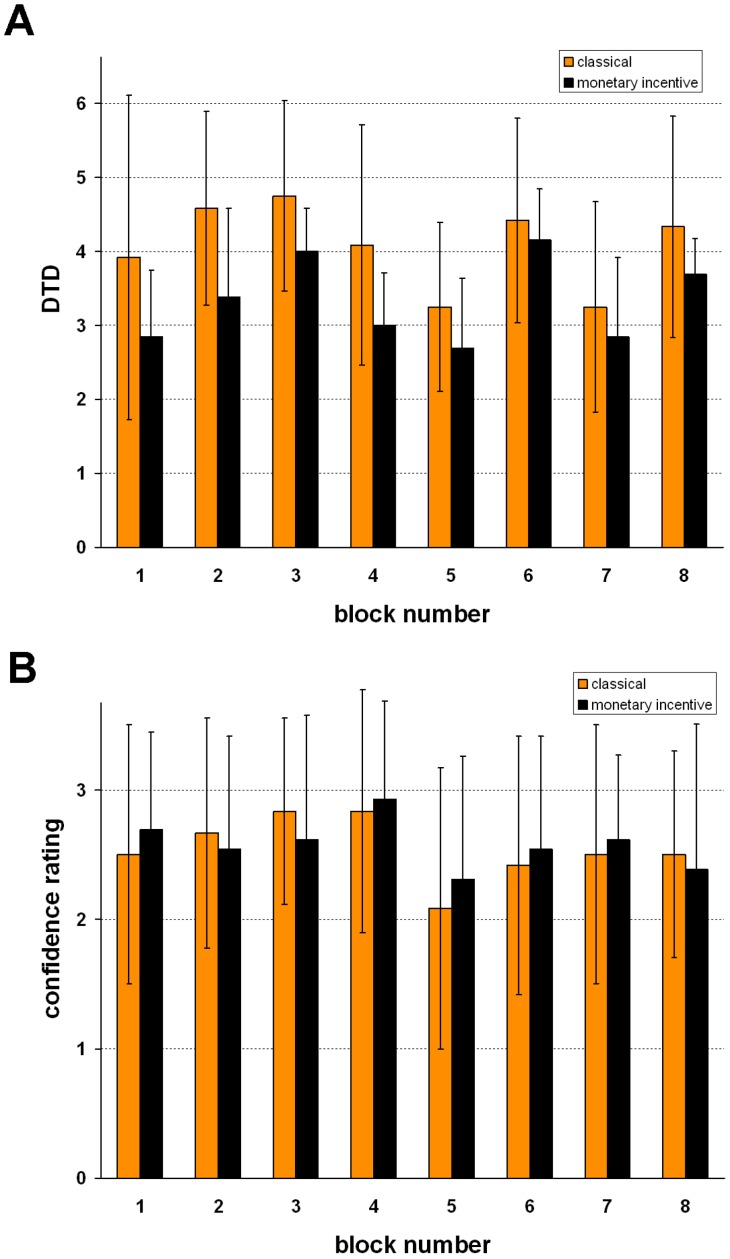
Means and standard deviations.
A: Number of fish viewed per block before the decision was taken (draws to decision = DTD). B: Confidence ratings per block. (grey = classical version, black = monetary incentive version of the task).